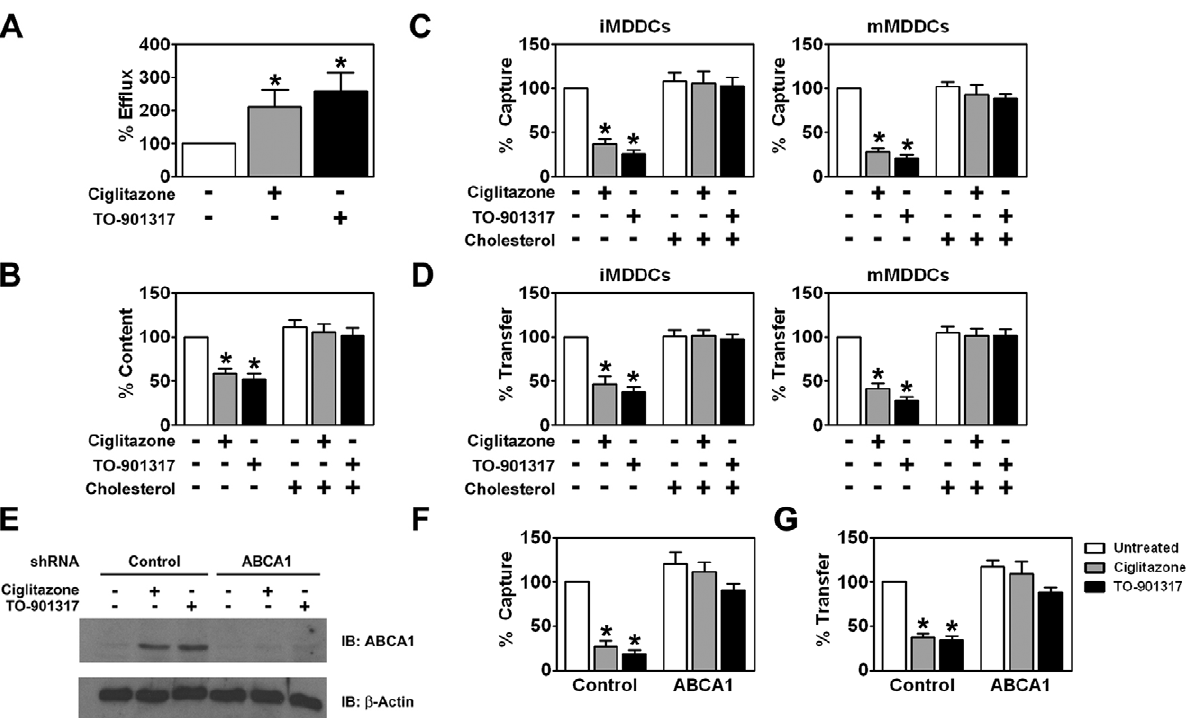
Figure 9. PPAR c and LXR signaling inhibit HIV-1 capture and transfer by MDDCs via ABCA1-dependent cholesterol efflux. (A) iMDDCs were treated for 48 hours with 100 m M ciglitazone or 1 m M TO-901317 and cholesterol efflux into the culture supernatant was measured. (n=3) (B) iMDDCs were treated for 48 hours with 100 m M ciglitazone and 1 m M TO-901317. The cells were then lysed and cholesterol content of the cell lysates was measured. (n=3) (C-D) Immature (left panel) and mature (right panel) MDDCs were treated with 100 m M ciglitazone or 1 m M TO- 901317 for 48 hours. NR ligand-treated cells were then incubated with 300 m M cholesterol in the form of cholesterol-saturated methyl- b -cyclodextrin. Following cholesterol repletion, the cells were used in capture (C) and transfer assays (D) as described in the legend of figure 2. (n=3) (E) iMDDCs transfected with either control shRNA or shRNA directed against ABCA1 were treated for 48 hours with 100 m M ciglitazone or 1 m M TO-901317. Levels of ABCA1 and b -actin were measured by immunoblot using an anti-ABCA1 and anti- b -actin antibodies, respectively. (n=3) (F) iMDDCs transfected with either control shRNA or shRNA directed against ABCA1 were treated for 24 hours with 100 m M ciglitazone (gray bars) or 1 m M TO-901317 (black bars). The MDDCs were then incubated with HIV-1 ADA and virus capture was measured by p24 gag ELISA. (n=3) (G) iMDDCs transfected with either control shRNA or shRNA directed against ABCA1 were treated for 24 hours with 100 m M ciglitazone (gray bars) or 1 m M TO-901317 (black bars). The MDDCs were then incubated with HIV-1 ADA , washed extensively, and then incubated with autologous T cells. Virus transfer was measured by p24 gag ELISA. Transfer assays with shRNA-treated DCs were performed using cells from two independent donors. * p , 0.001 compared to untreated controls.